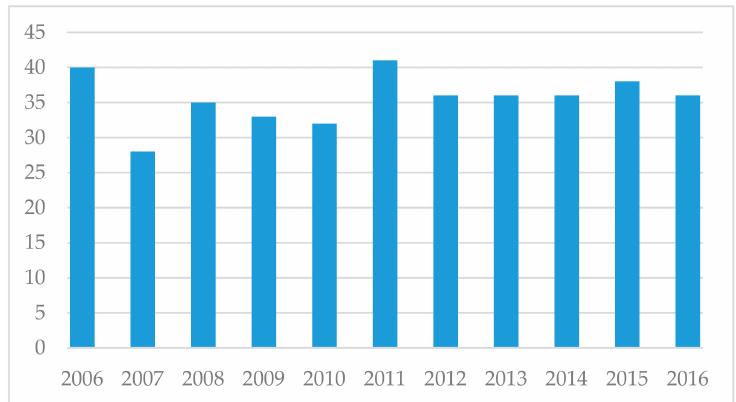
Figure 1. Number of Participants in the UVM / NOFA Organic Dairy Profitability Study